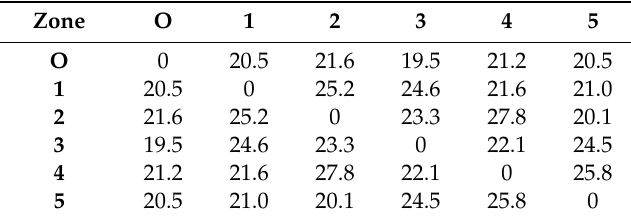
Table 11. Travel distances (km) from the cluster centroids.